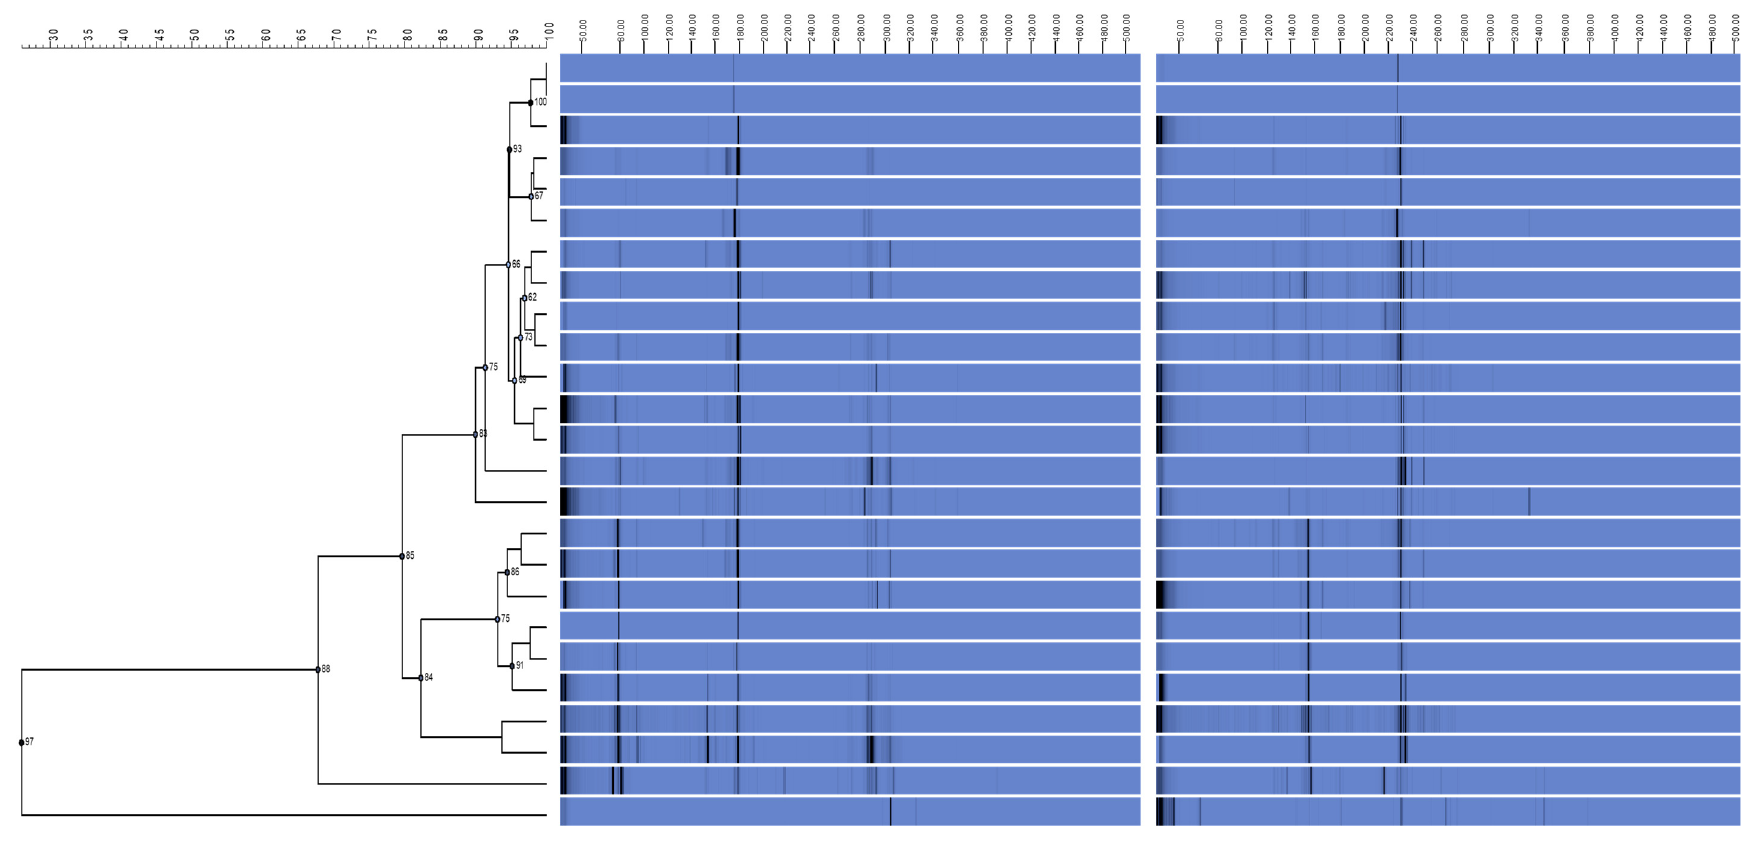
Figure 1. Acinetobacter baumannii relationships are depicted in this dendrogram. Using the unweighted pair group method of arithmetic averages of Acinetobacter baumannii REP-PCR DNA fingerprints, the dendrogram was built. Imipenem resistance profiles, Acinetobacter isolates , and REP-PCR fingerprints are all displayed. The dotted vertical line indicates the 90% similarity threshold.